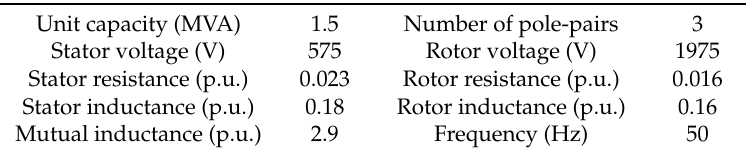
Table 2. Parameters of the doubly fed induction generator (DFIG).